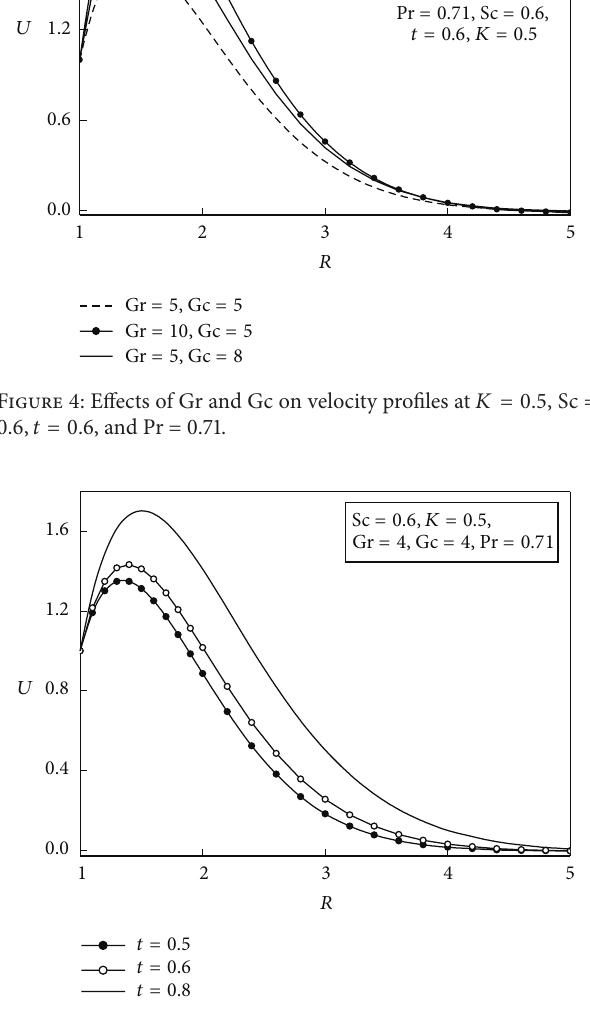
Figure 3: Effect of Sc on velocity profiles for Pr = 0.71 and 7 at 𝐾 = 0.6 , Gr = 5, Gc = 5, and 𝑡 = 0.6 .